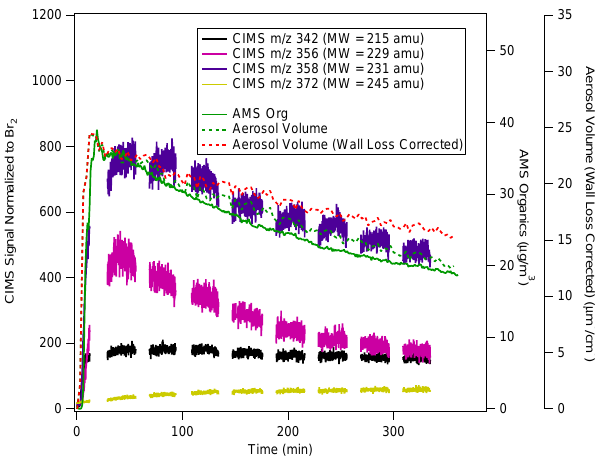
Figure 2. Time series of the gas-phase organic nitrate species mea- sured by the CIMS and the corresponding aerosol formation mea- sured by HR-ToF-AMS (organics mass) and SMPS (aerosol vol- ume) (Experiment 30 in Table 1). The gas-phase species at m/z 356 decreases over the course of the experiment while the species at m/z 372 increases